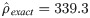
Log-likelihood curves for the exponential model of population growth for data on segregating sites from the mtDB database [25].Each segregating site from Table 2 was treated as a separate SNP. The curve marked with asterisks shows the exact log likelihood function and the one marked with open circles is the approximate log likelihood function. The maximum of the exact log likelihood function is attained at ρ^exact=339.3 and the maximum of the approximate log likelihood function is attained at ρ^approx=341.7.